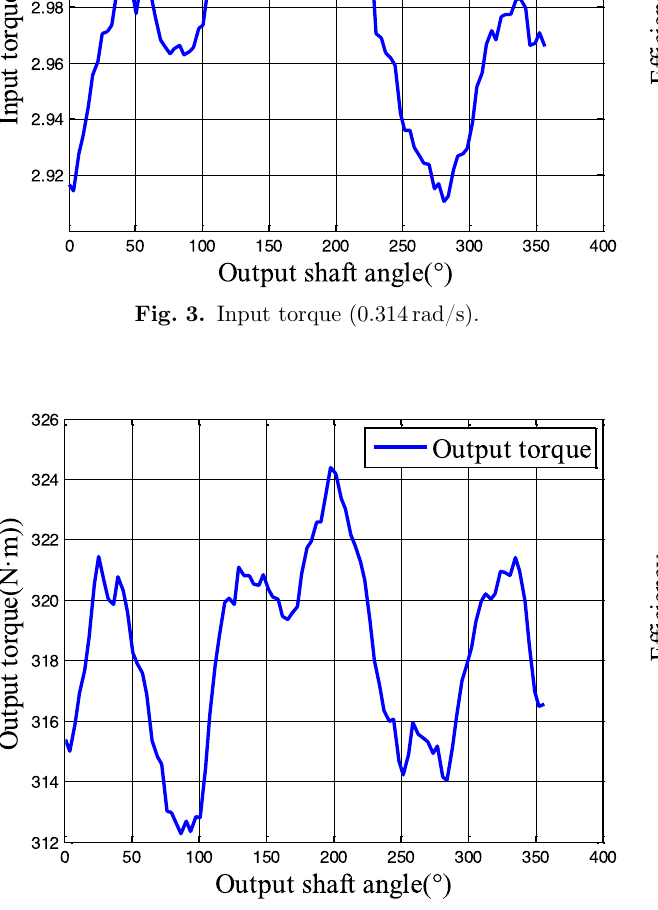
Fig. 4. Output torque (0.314rad/s).